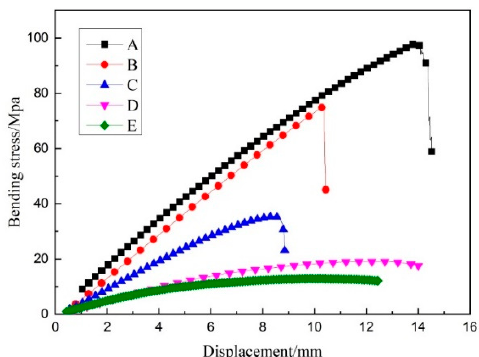
Figure 10. Weft stress–displacement curve.